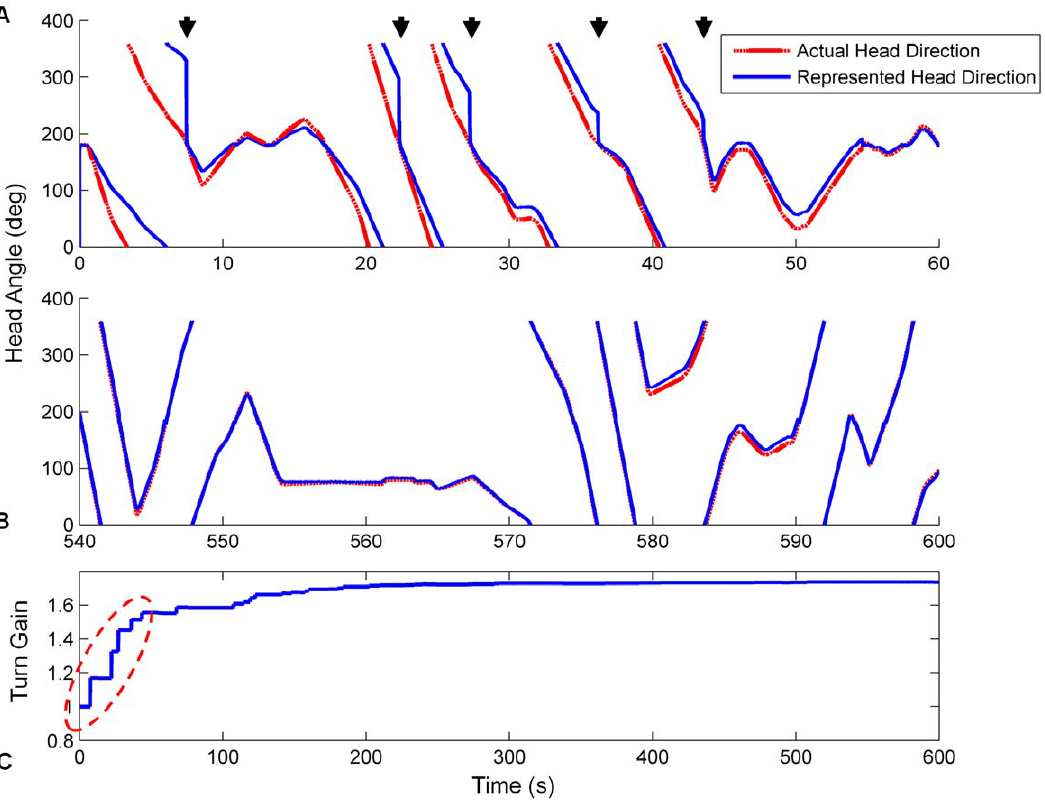
Figure 5. Head direction tracking improved as turn gain was calibrated. Actual and represented head directions were tracked for the first and final 60 seconds of training (respectively graphs (A) and (B)). X axis – time in seconds, Y axis – head orientation in degrees, dashed red – actual head position, solid blue – head position as represented in the HDAAN. (A) At the commencement of training, the HD bump consistently under-turned and therefore lagged behind actual head direction. At this stage, large HD landmark resets occurred each time the actual head direction passed through the landmark position at 180 u (indicated by solid vertical lines in the represented head direction and marked with arrows). The HD resets became progressively smaller as training progressed due to adjustment of the turn gain by the ongoing calibration. (B) At the completion of training, the represented head direction tracked actual head direction almost perfectly. The slight discrepancies apparent between actual head direction and the HD bump position from 580 to 590 seconds were due to HD reset being performed during fast head turns; during the reset, which took a short time, the head continued to turn slightly past the reset position, causing head direction to lag slightly even when the turn gain was correctly calibrated. (C) Turn gain was initialized to 1.0 prior to training and within 5 minutes (300 seconds) it reached its correctly calibrated value of 1.735, from which time the calibration remained stable. The first five gain adjustments (circled in (C)) correspond to the five arrowed head direction resets shown in (A).